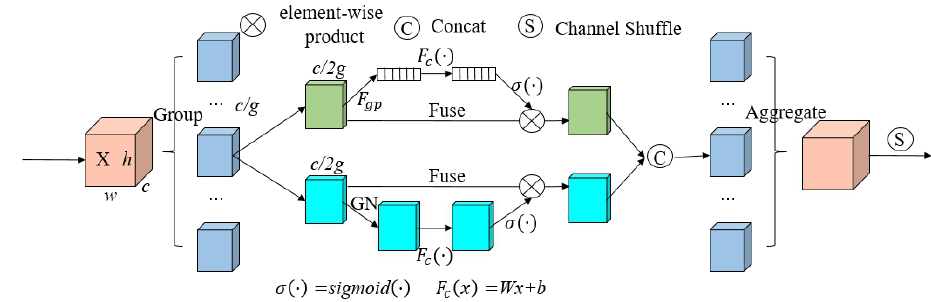
Figure 7. Shuffle attention schematic.